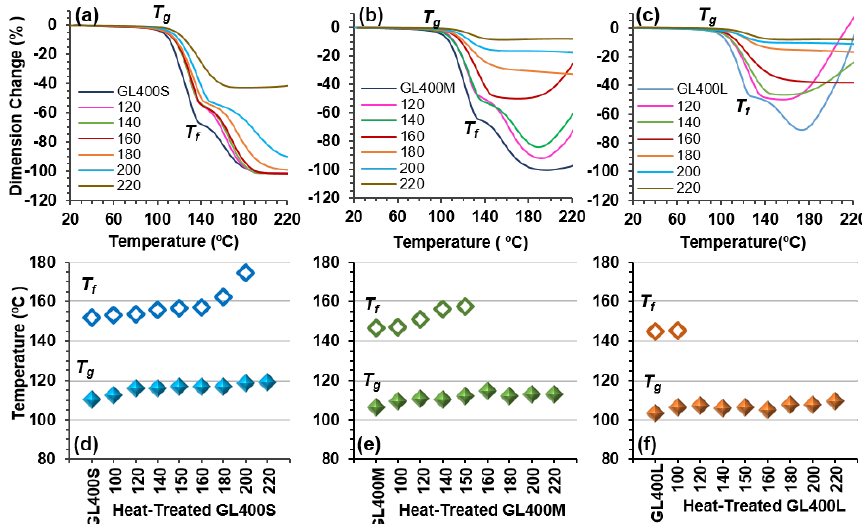
Figure 4. TMA profiles of the heat-treated GL400S ( a ), GL400M ( b ), GL400L series ( c ) and the respective thermal transition temperature, glass transition temperature ( T g ), and viscous thermal flow temperature ( T f ) for the GL400S ( d ), GL400M ( e ), and GL400L series ( f ). The samples were subjected to heat treatment at temperatures of 100–220 °C for 1 h.